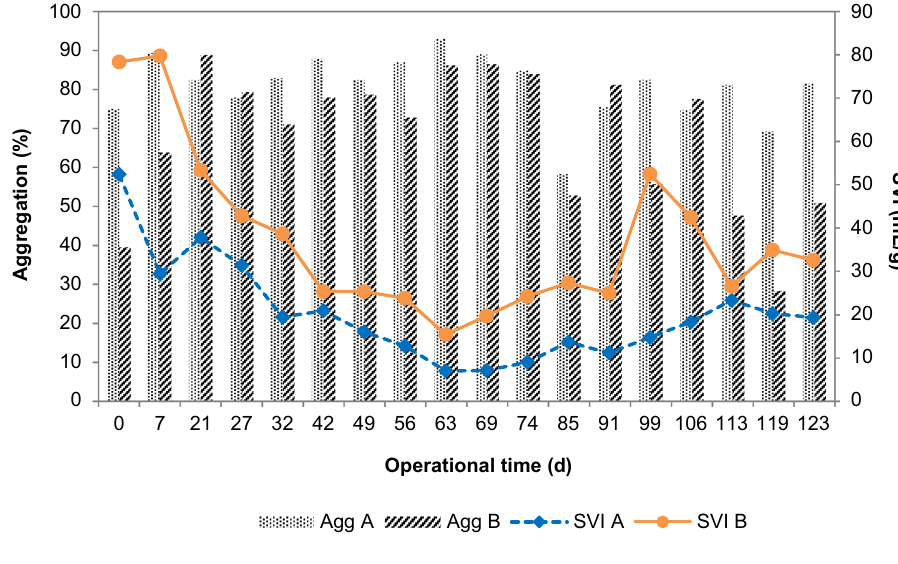
Fig. 3 Aggregation and SVI profiles of biomass for SBR A and SBR